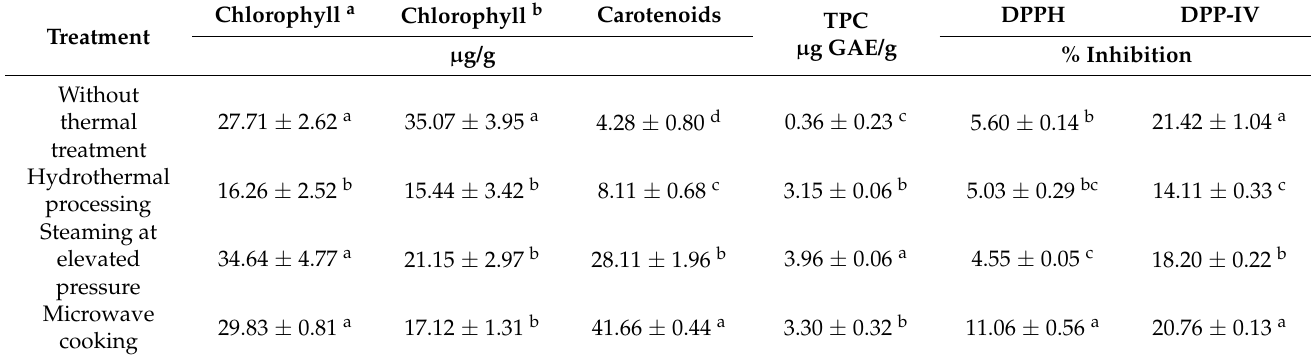
Table 2. Effect of thermal treatment on chlorophyll a and b, total carotenoids, total phenolic com- pounds, and other nutraceutical characteristics of Pacaya